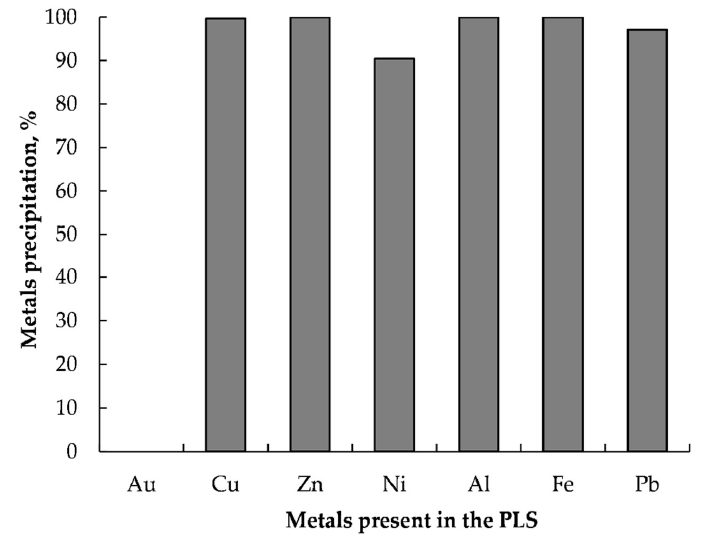
Figure 10. Removal of metal impurities from the pregnant leach solution (PLS) by precipitation at pH 9.